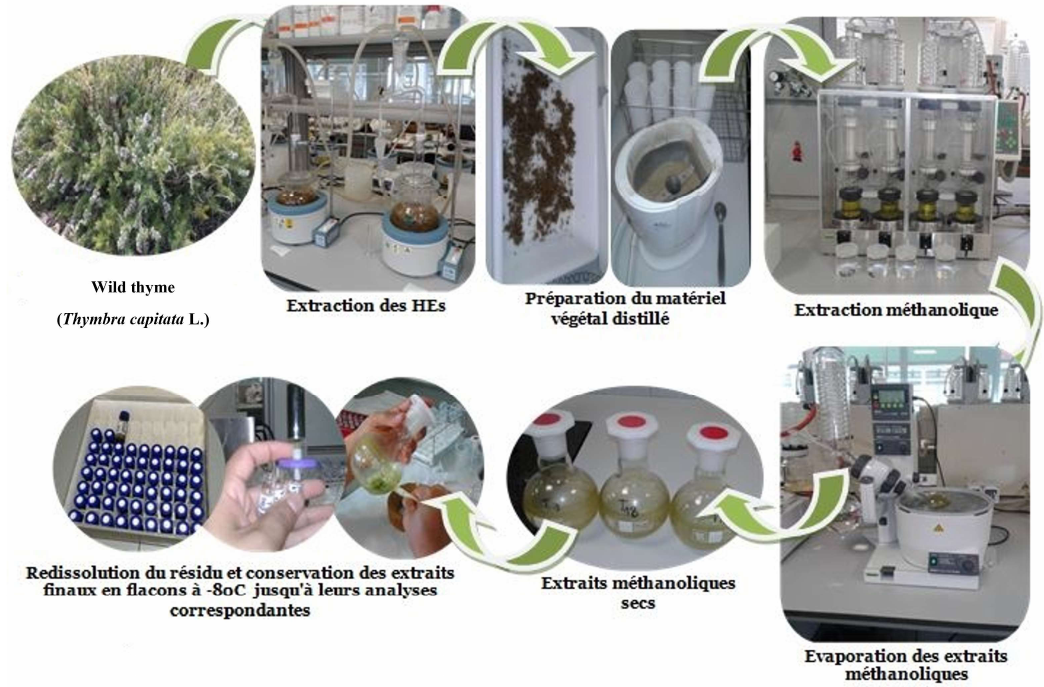
Figure 3. Preparation of methanolic extracts of post-distilled thyme.